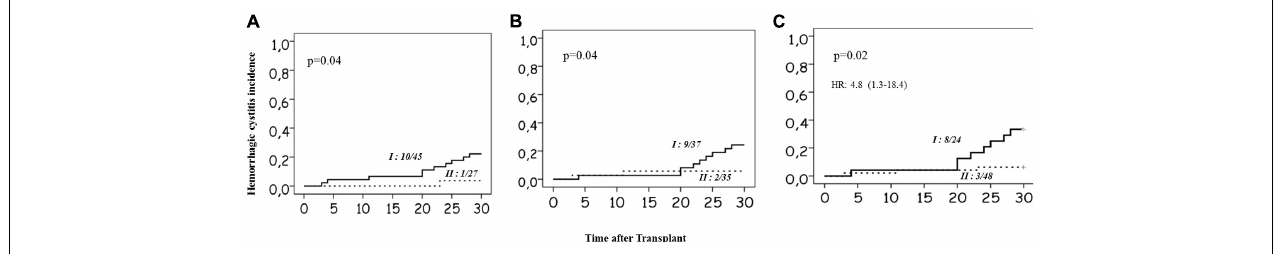
FIGURE 3 | Incidence of Hemorrhagic cystitis. (A) in relation to the CYP2C9 genotype status. Group I represents patients without dysfunctional alleles, and II represents carriers of at least one dysfunctional allele. (B) In relation to GSTM1 genotype, group I represents nonNull carriers; and group II represents Null allele carriers. (C) In relation to combined CYP2C9 and GSTM1 genotypes group I represents carriers of normal functional CYP2C9 and GSTM1 genotypes and group II represents carriers of at least one dysfunctional allele in either CYP2C9 or GSTM1 or both. Number of patients with HC/total number of patients in each group and p -values are mentioned on the plots. Multivariate Cox-regression p -value and hazards ratio with 95% confidence intervals are mentioned for 3C.